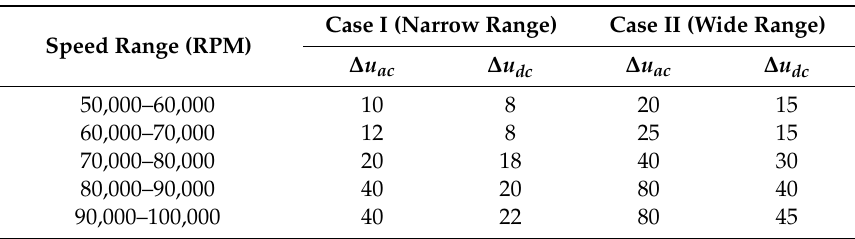
Table 4. Di ff erent operating conditions for